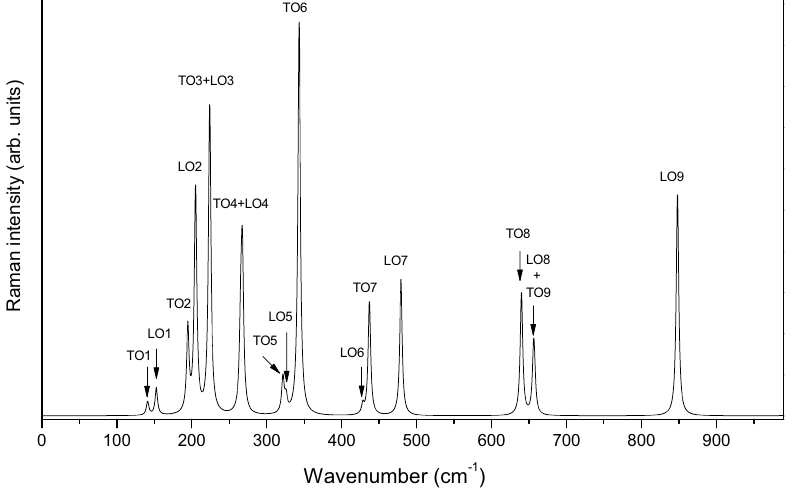
Figure 9. The calculated Raman spectra of the LiNbO 3 -type ZnTiO 3 for a x(yz)y scattering configuration of E modes in the range of 0~1000 cm − 1 .